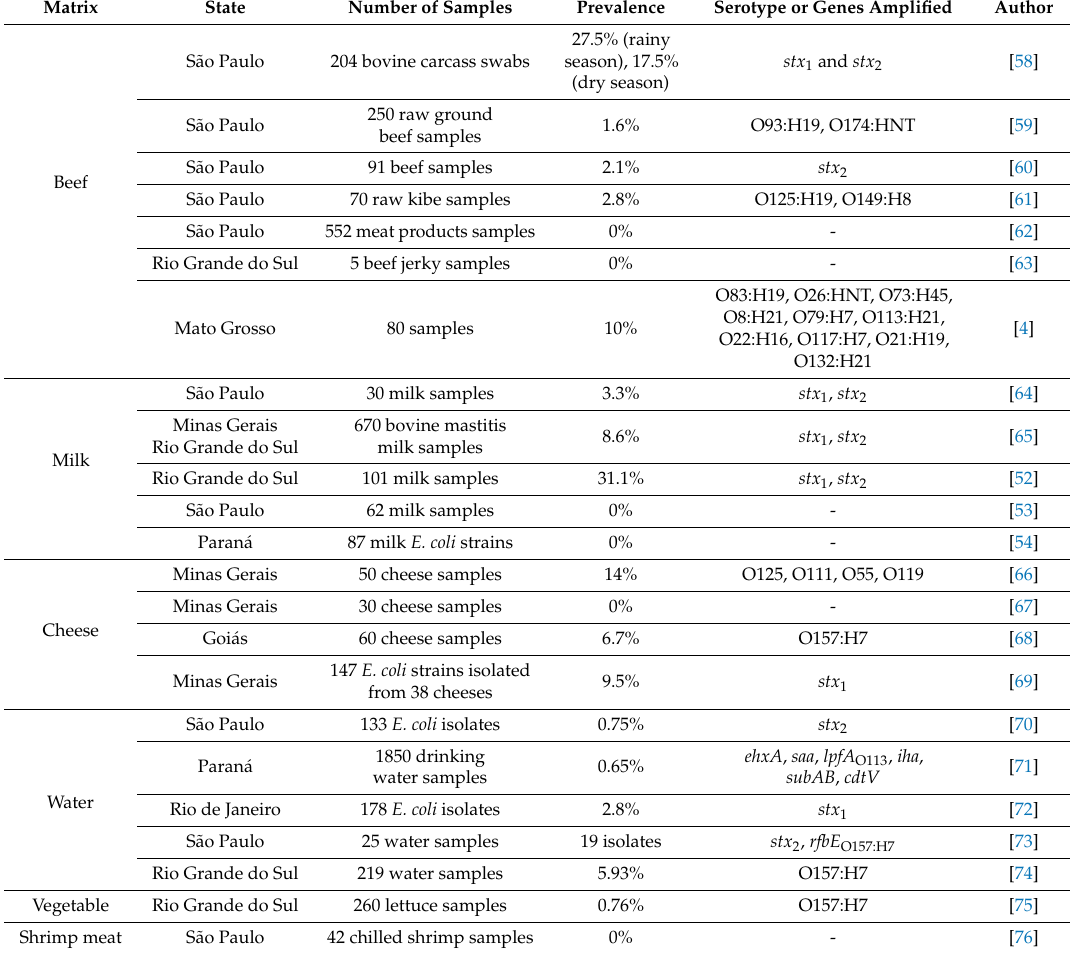
Table 2. Prevalence of Shiga toxin-producing Escherichia coli isolated in food produced in Brazil.